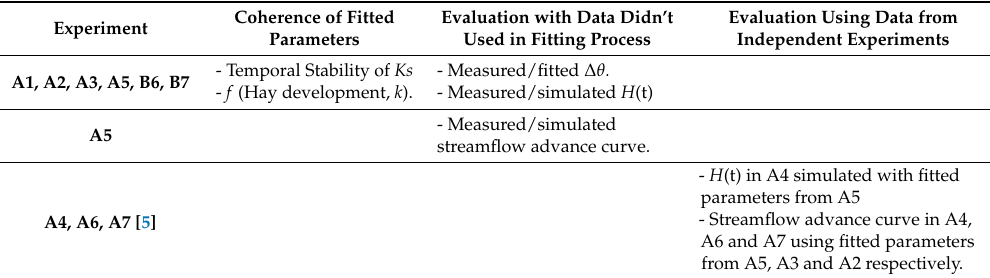
Table 3. The three steps of the evaluation strategy of the fitting process. Step one (“coherence”) is used to check the physical meaning of the fitted parameters; step two (“evaluation with experiments used for the inverse modelling”) is a “weak validation” performed on data which were not used in the inversing process; Step three (“evaluation with experiments had not submitted in the inverse modelling”) is the validation sensu